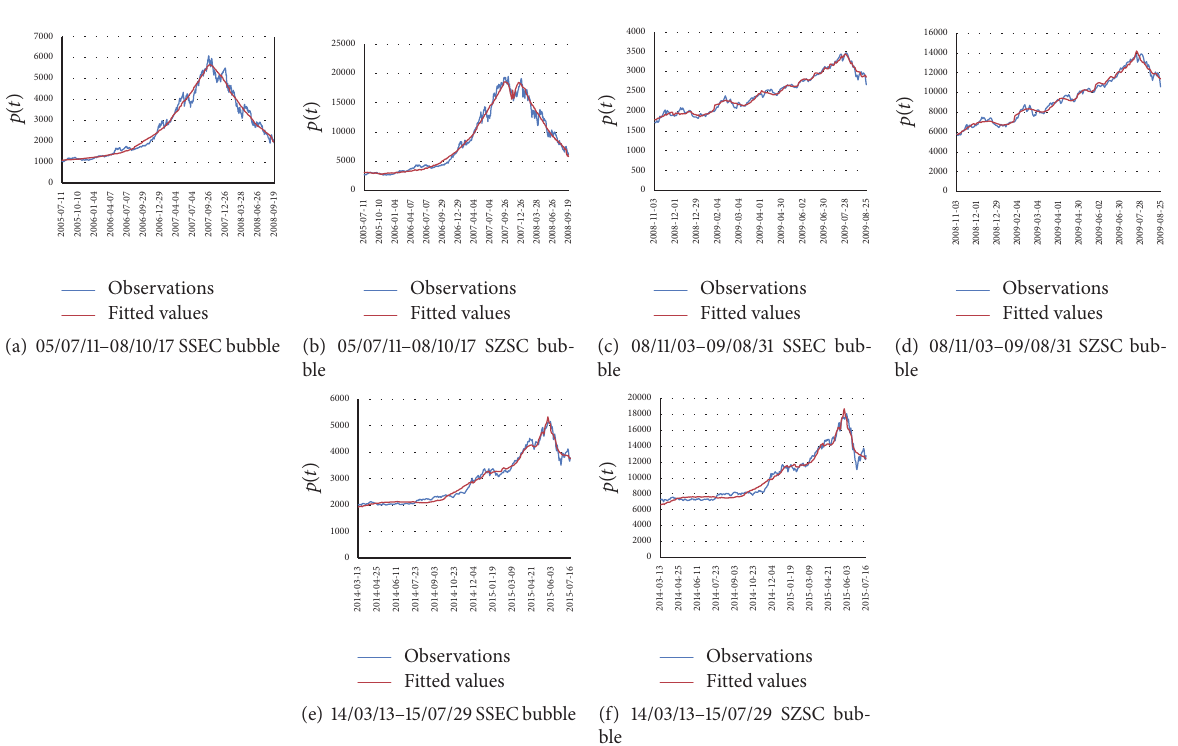
𝜔 = 0.03, 𝑚 = 𝑐 = 2007/10/16, 𝜔 = 1.26, 𝑐 = 2007/11/26,